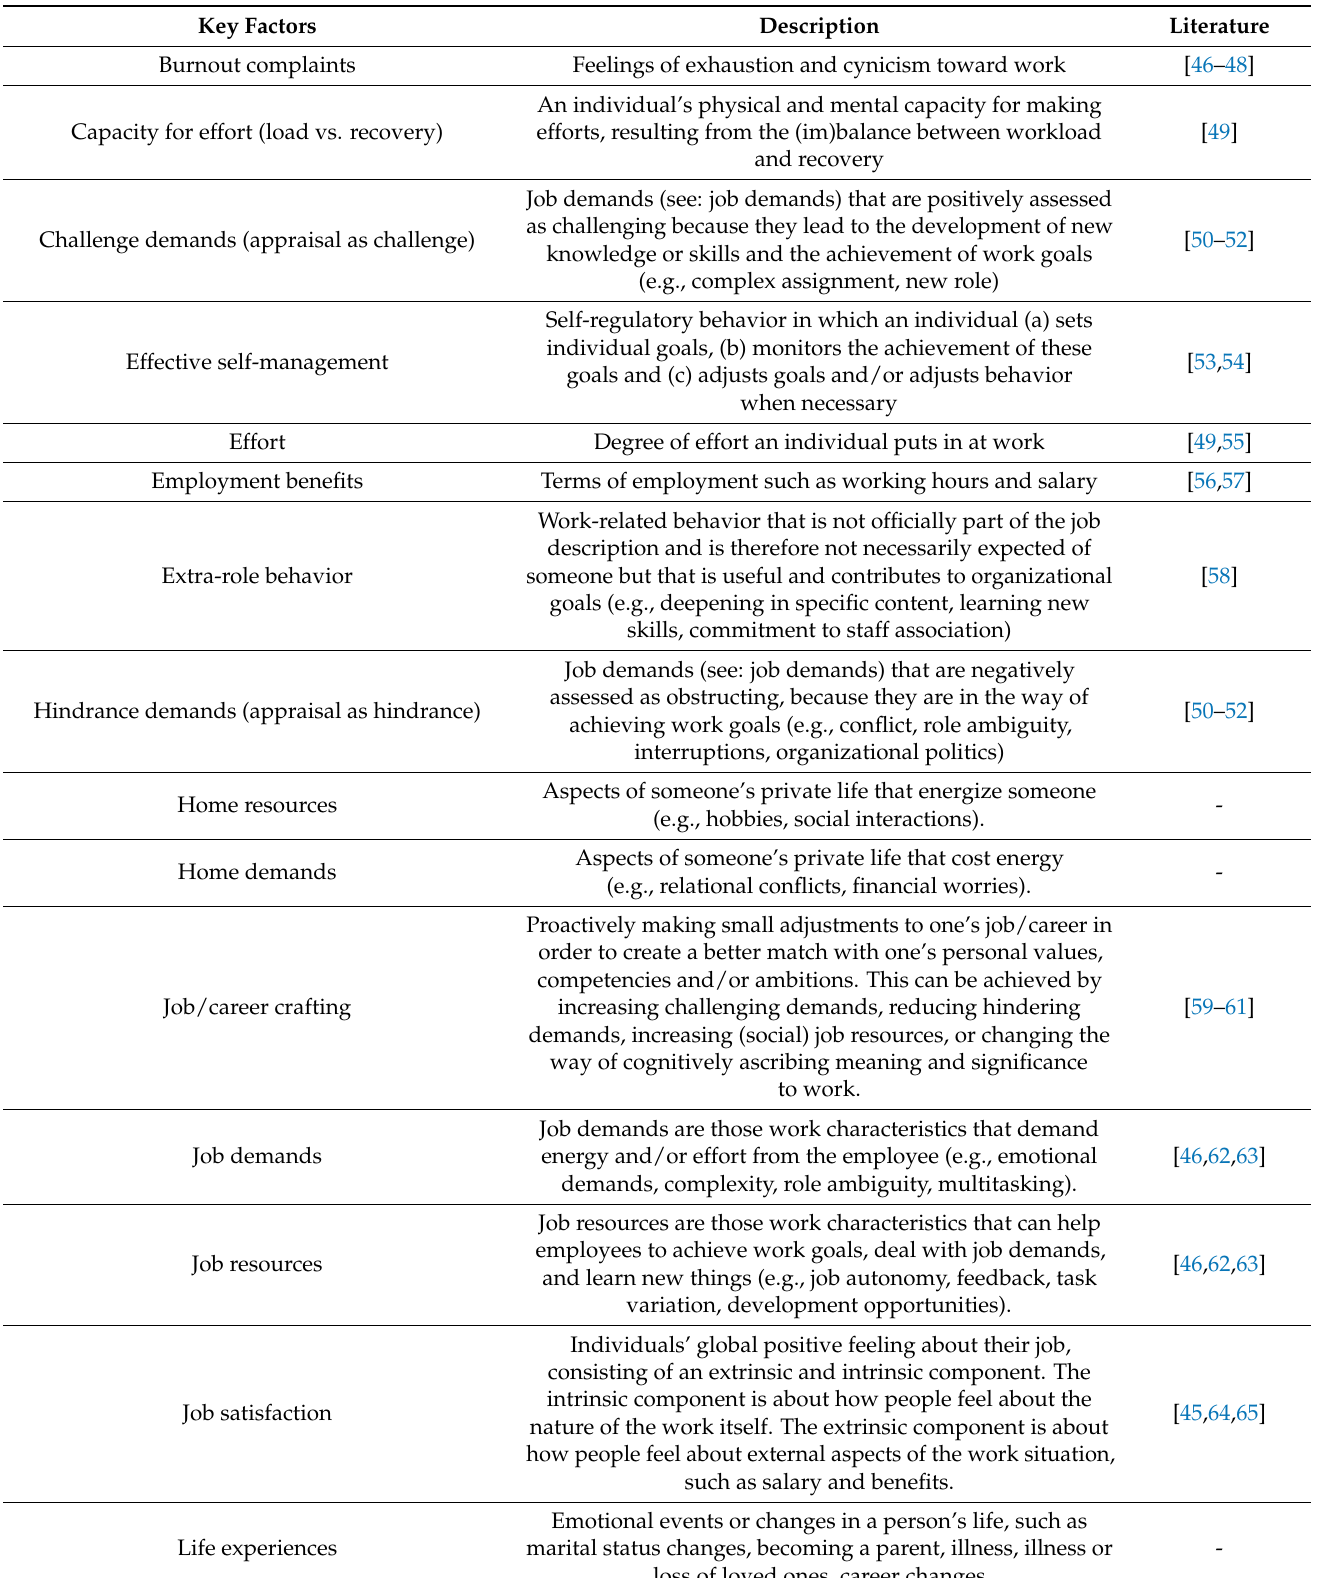
Table 1. Key factors relating to workplace well-being, description of key factors and examples of relevant